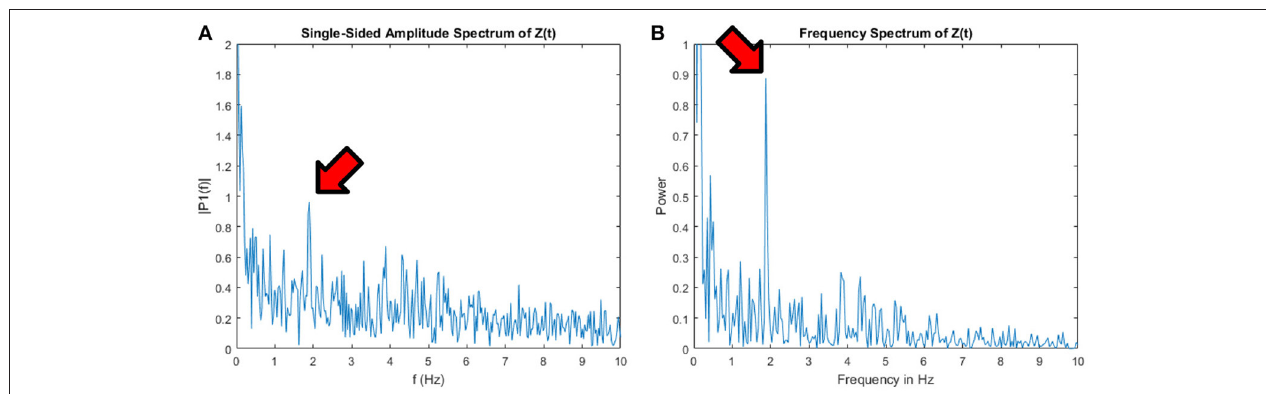
FIGURE 4 | (A) Frequency feature detected at 2Hz, at indoor range of 7.62m. (B) The same spectrum smoothed using MATLAB pwelch function, yielding an enhanced feature.